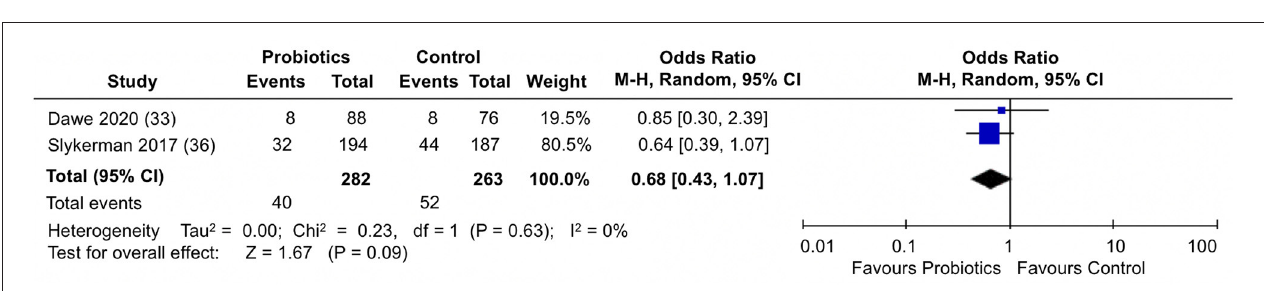
FIGURE 4 | Meta-analysis of the effect of probiotic supplementation on EPDS depression scores in the perinatal period.